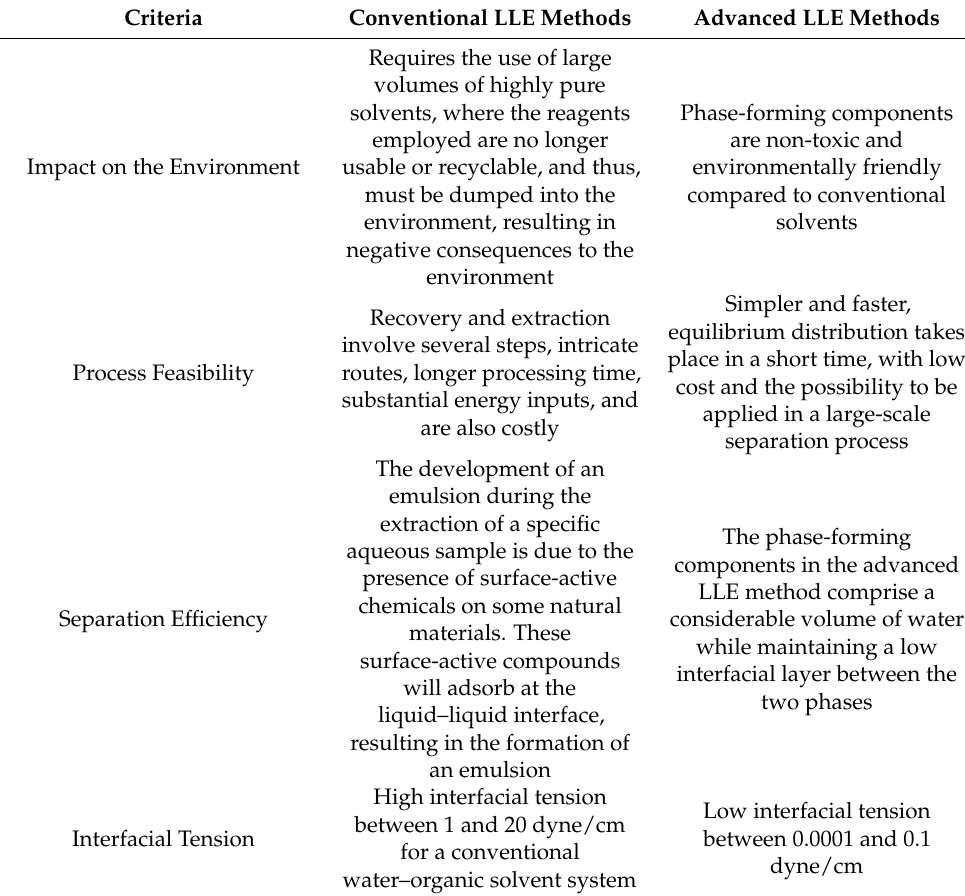
Table 2. The comparison between conventional and advanced LLE